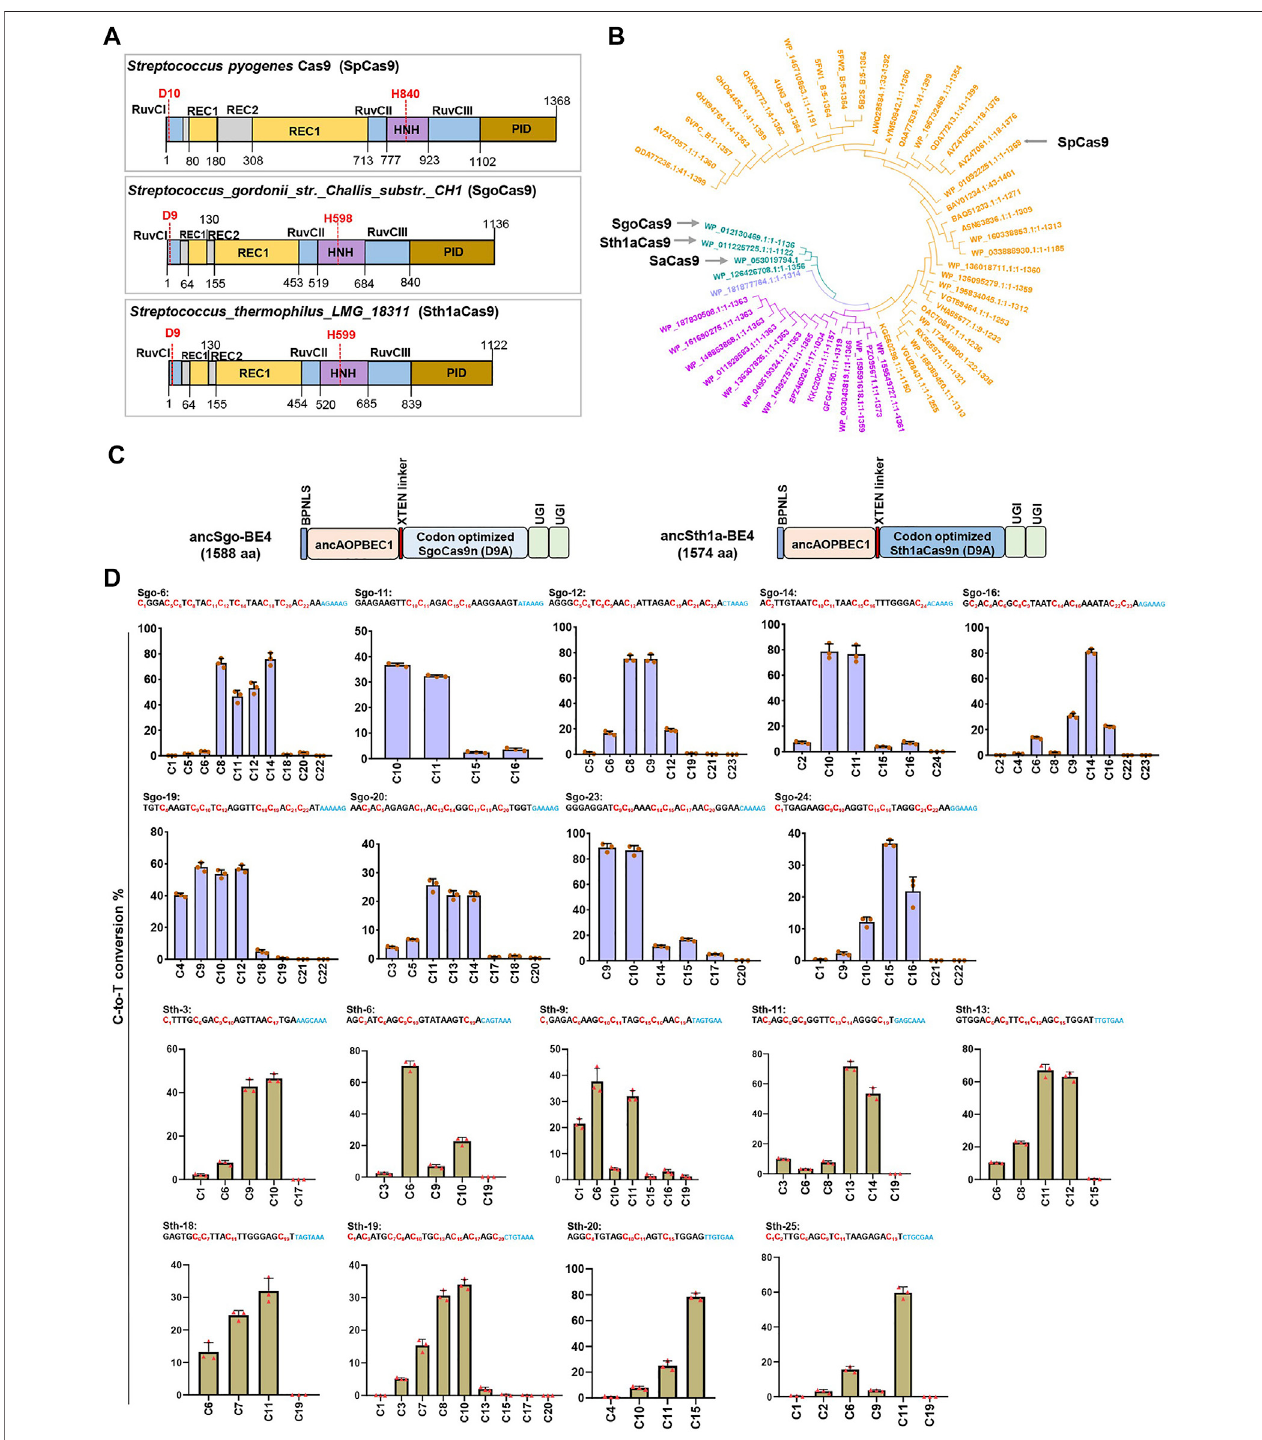
FIGURE 1 | Construction of two novel CBEs. (A) Architectures of the SpCas9, SgoCas9, and Sth1aCas9. (B) Unrooted phylogenetic tree of selected Cas9 orthologs from differentbacterialstrainsfor activity screening. Four speci fi ed Cas9 orthologs (spCas9, saCas9, SgoCas9, and Sth1aCas9)are indicated. (C) Schematic diagram showing plasmid architectures of ancSgo-BE4 and ancSth1a-BE4. (D) The C-to-T conversion rates induced by ancSgo-BE4 and ancSth1a-BE4 at indicated target DNA sites in HEK293T cells were presented. Error bars represent standard error from three independent experiments. The sequences represent gRNA target and PAM sequences (blue), and the cytosines are ordered and highlighted in red.